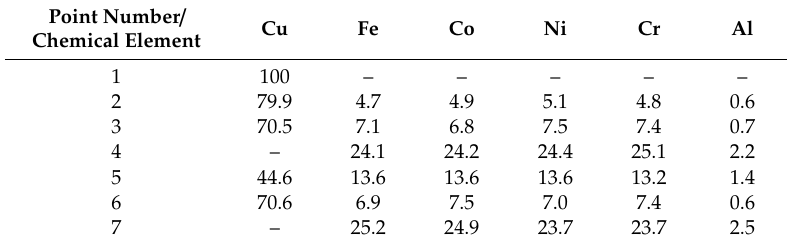
Table 3. Chemical composition of corresponding points in Figure 3d